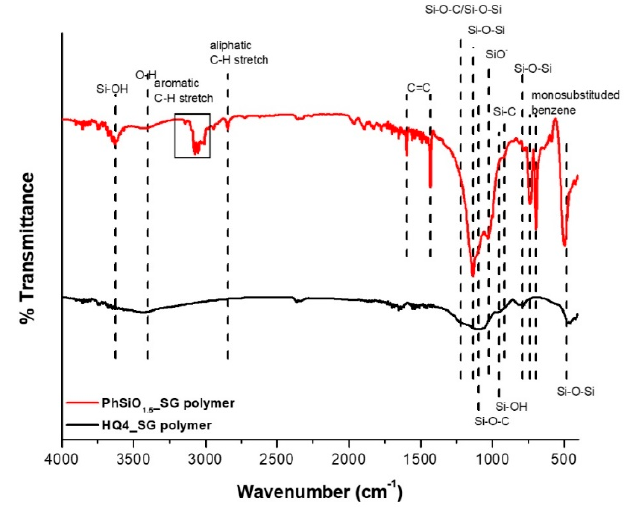
Figure 3. FTIR spectra of HQ4_SG and PhSiO 1.5 _SG polymers.